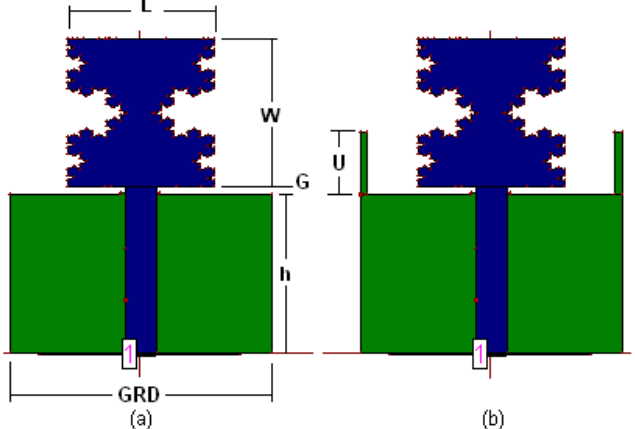
Figure 6: The layouts of the modeled Koch fractal monopole antennas with (a) typical ground plane and (b) virtually extended ground